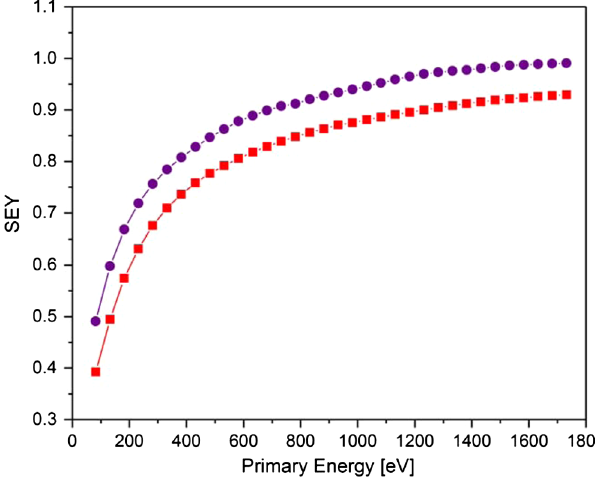
FIG. 8. Secondary electron yield of a University of Dundee LH sample as received (red squares) and after 12 months of aging (purple circles).